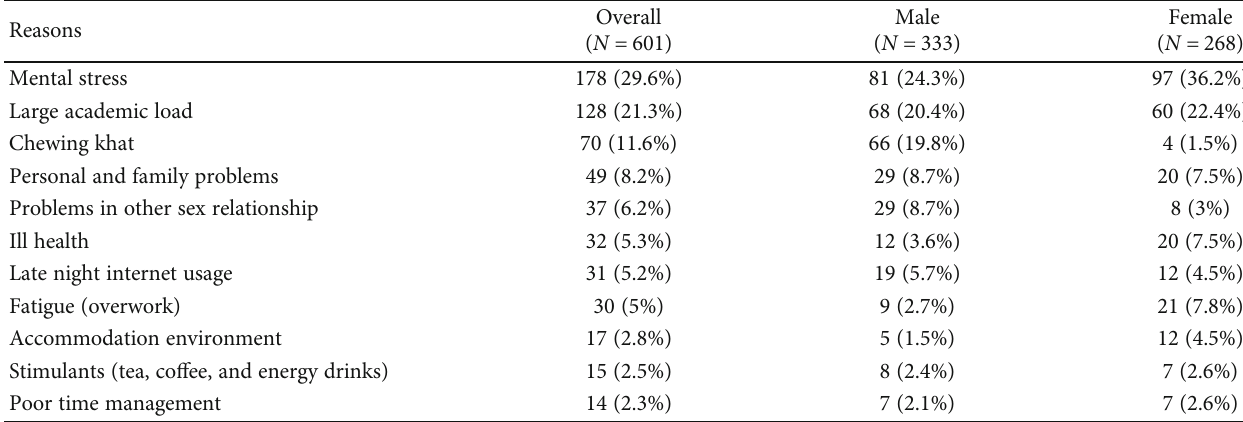
Table 4: Students ’ reasons of sleep disturbances.